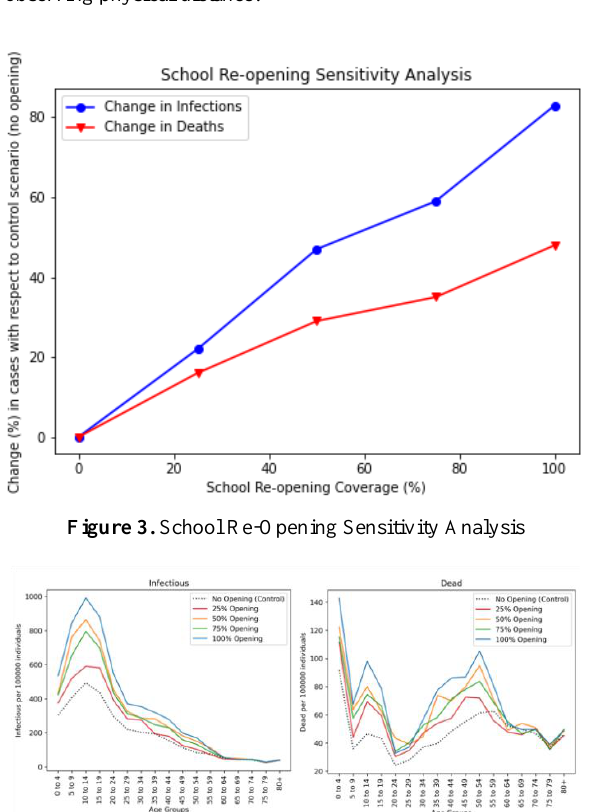
Figure 4 . Age distribution of projected infections and Deaths for Quezon City, Philippines under various school re-opening scenarios.